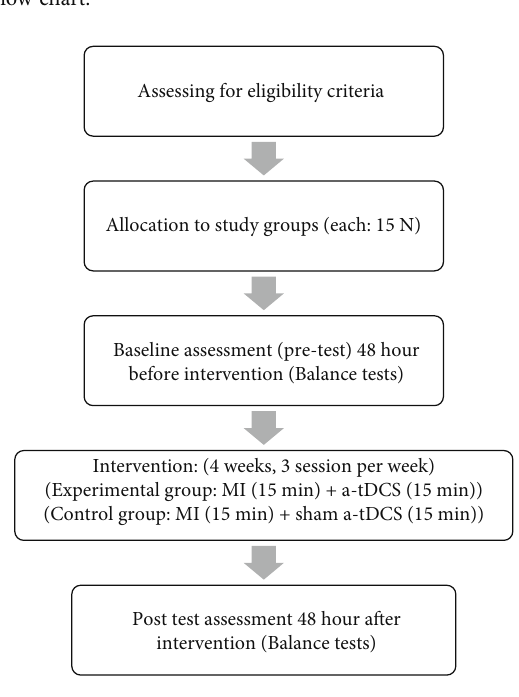
Assessing for eligibility criteria